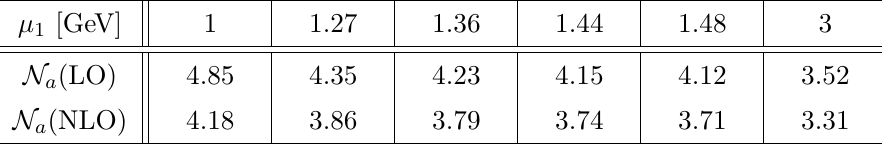
Table 4 . Comparison of N a at LO- and NLO-QCD, for different values of the renormalisation scale µ 1